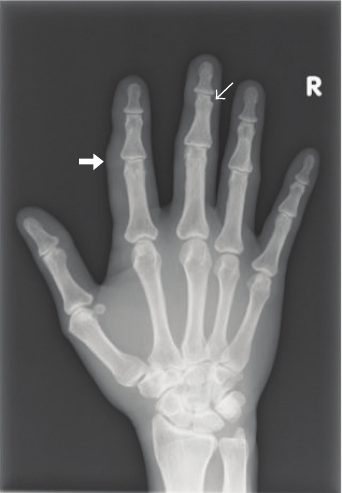
Figure 8: Frontal radiograph of the right hand shows focal periar- ticular soft tissue swelling at the proximal interphalangeal joint of the 2nd digit (thick arrow), suspicious for dactylitis. A small juxta- articular erosion is also noted at the middle phalanx of the middle finger (white arrow), which may represent the arthropathic changes related to HS.